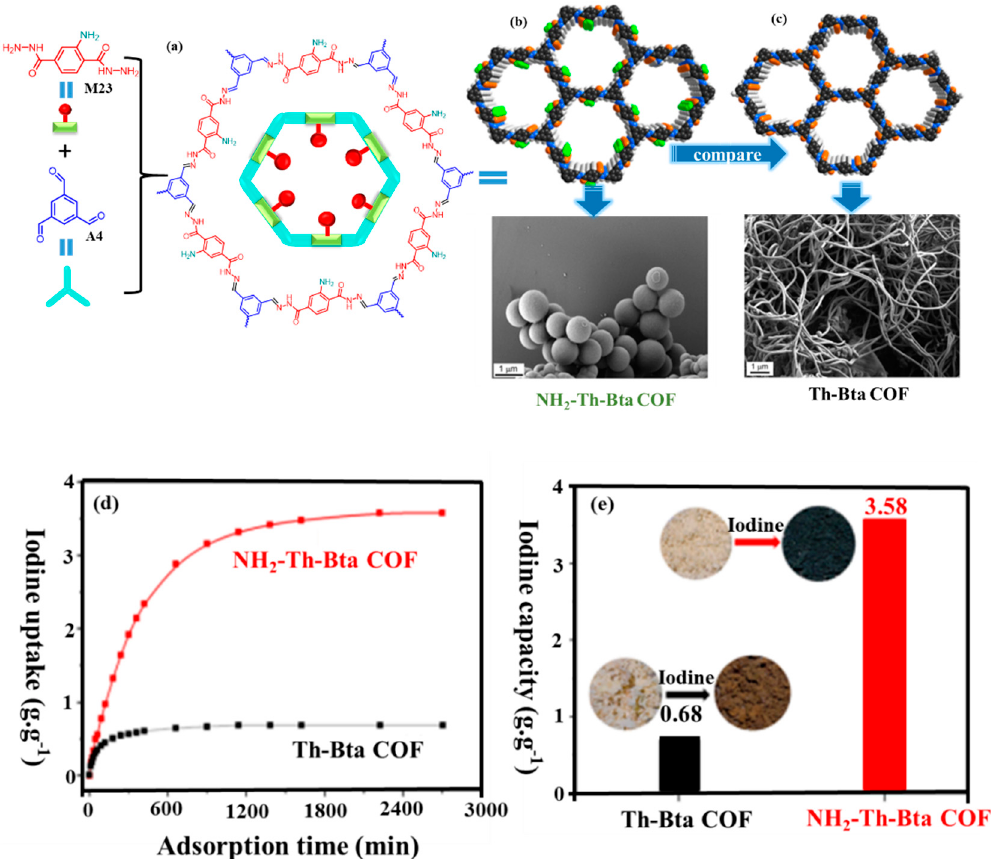
Figure 15. ( a ) Synthesis of the amine-functionalized NH 2 − Th − Bta COF using the site-selective syn- thetic strategy. ( b ) Simulated structure and SEM image of Th-Bta COF. ( c ) Simulated structure and SEM image of NH 2 − Th − Bta COF. ( d ) Iodine vapor adsorption on Th − Bta and NH 2 − Th − Bta COFs. ( e ) Comparison of the iodine uptake capacities of Th − Bta and NH 2 − Th − Bta COFs. Reprinted with per- mission from [75]. Copyright (2021), American Chemical Society.